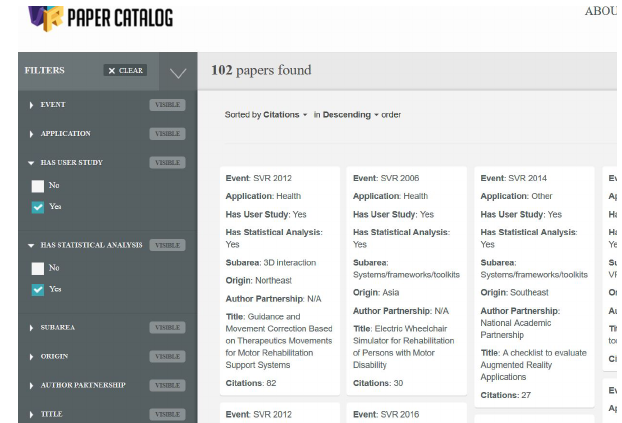
Figure 6. Open Catalog for the 22 years of SVR publications.